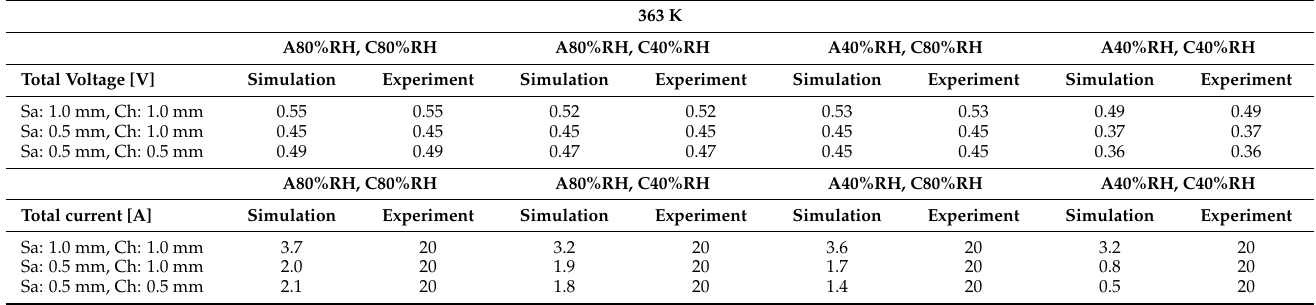
Table 8. Comparison of total voltage and total current between the numerical simulation in this study and the authors’ previous experimental study at 363 K [18]. 363 K